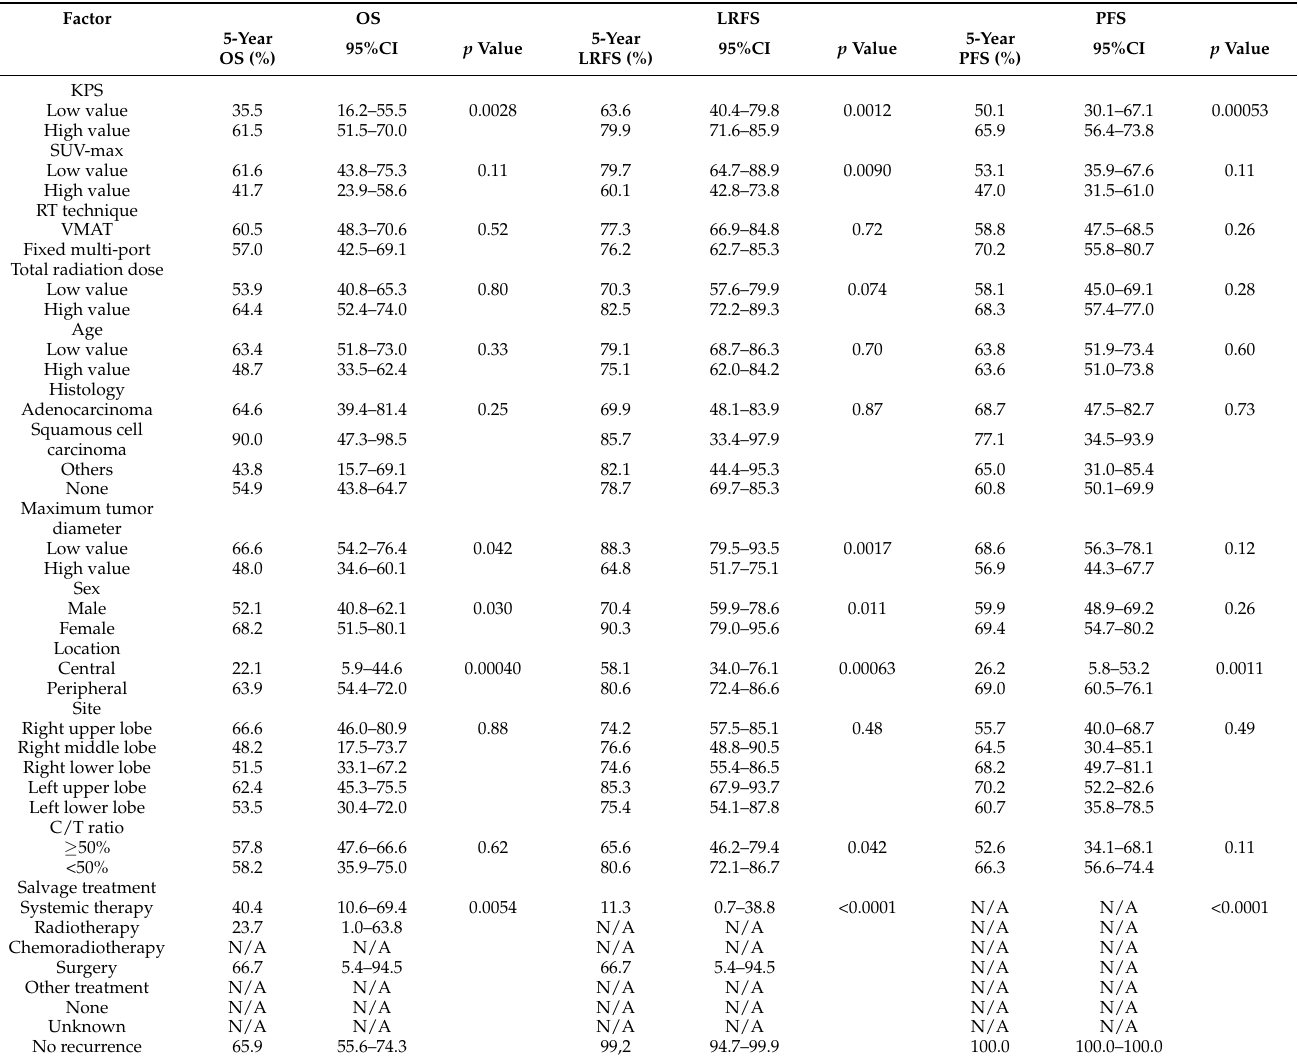
Table 2. Univariate analysis of background factors using the log-rank